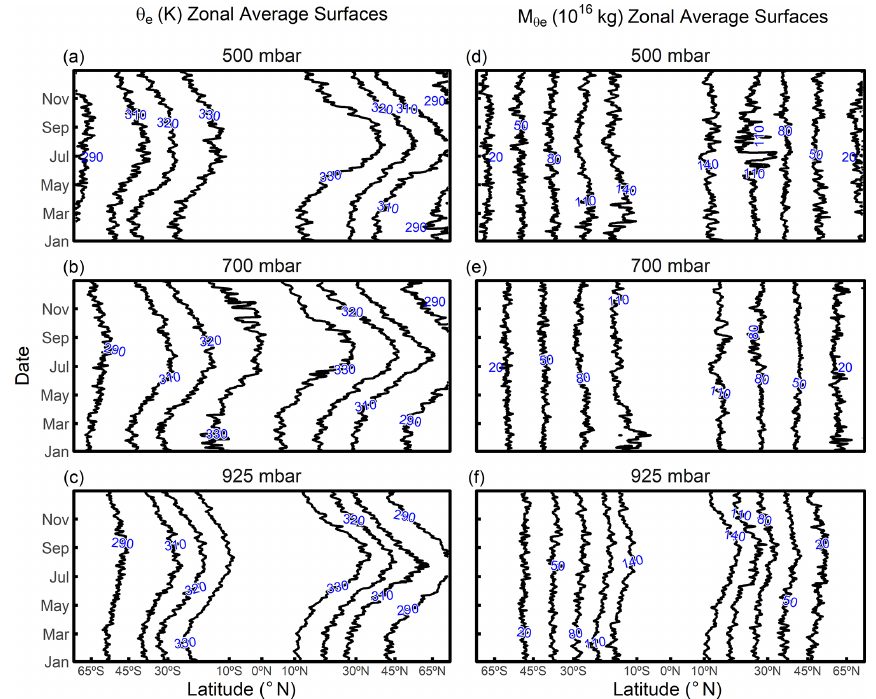
Figure 4. Time series of meridional displacement of selected zonal average θ e (K) surfaces over a year at (a) 500mbar, (b) 700mbar, and (c) 925mbar. Meridional displacement of selected zonal average M θ (f) 925mbar. The value of each surface is labeled. θ e and M θ